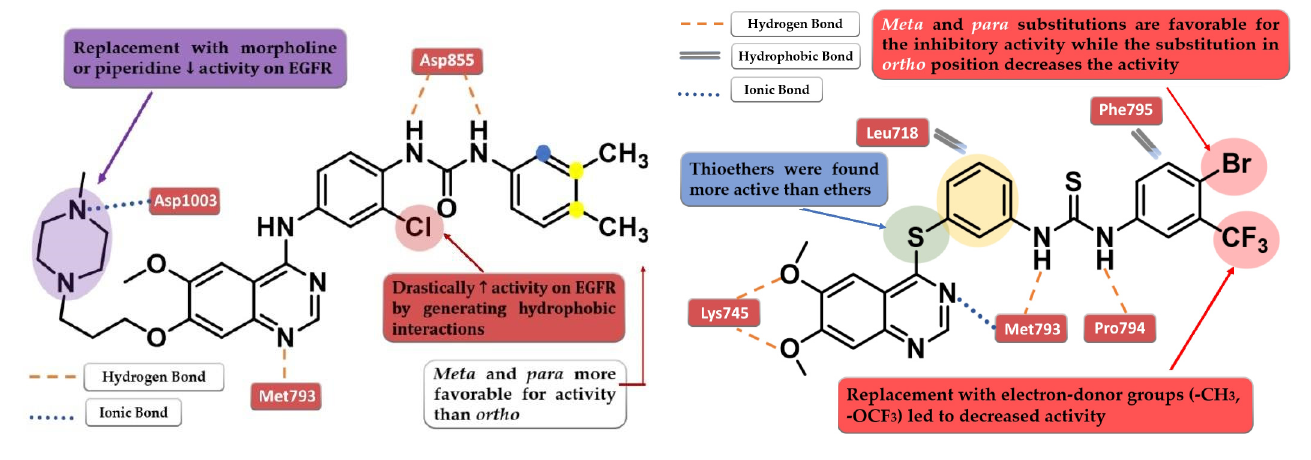
Figure 5. Structure–activity relationship and molecular docking of compound 5 in the human EGFR kinase domain (PDB ID 2ITY) [51], as reported by Zhang et al. [109]; structure–activity relationship and molecular docking of compound 6 in the human EGFR kinase domain (PDB ID 2ITY) [51], as reported by Sun et al.